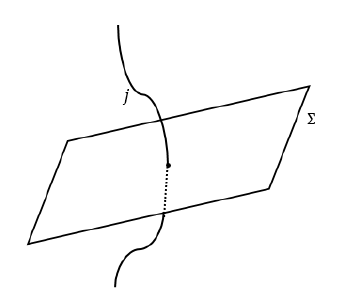
Figure 2. A diagram of surface puncture. See text for